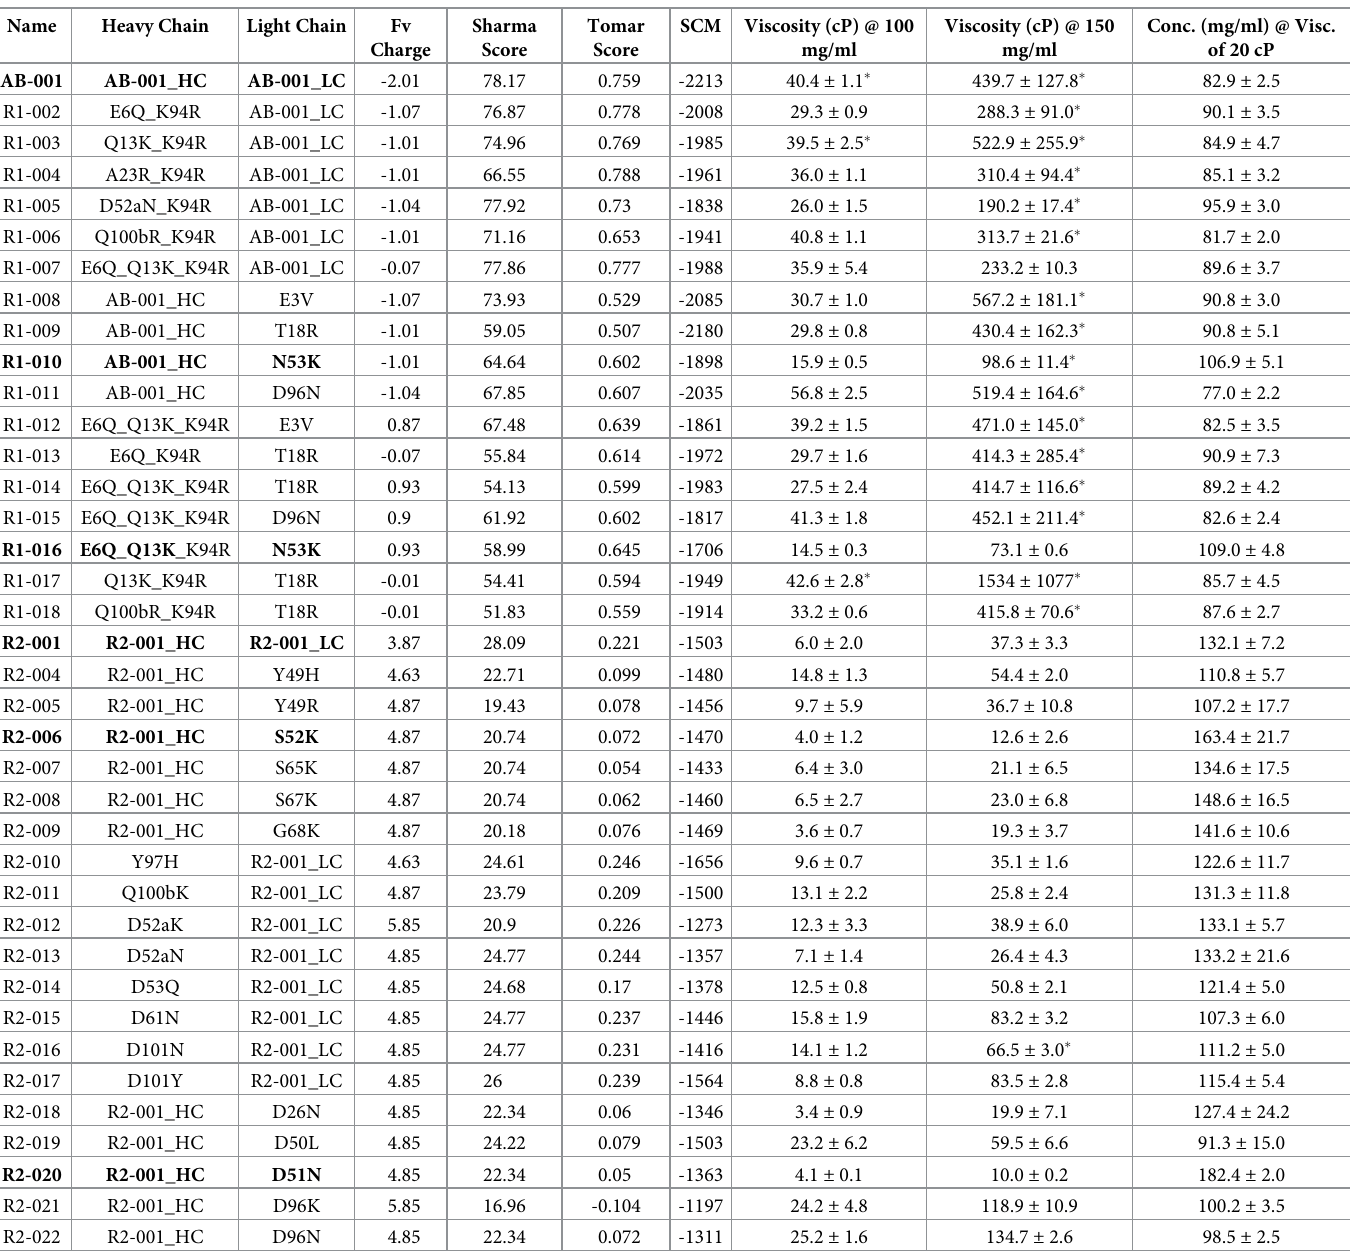
Table 3. In silico and viscosity properties of design